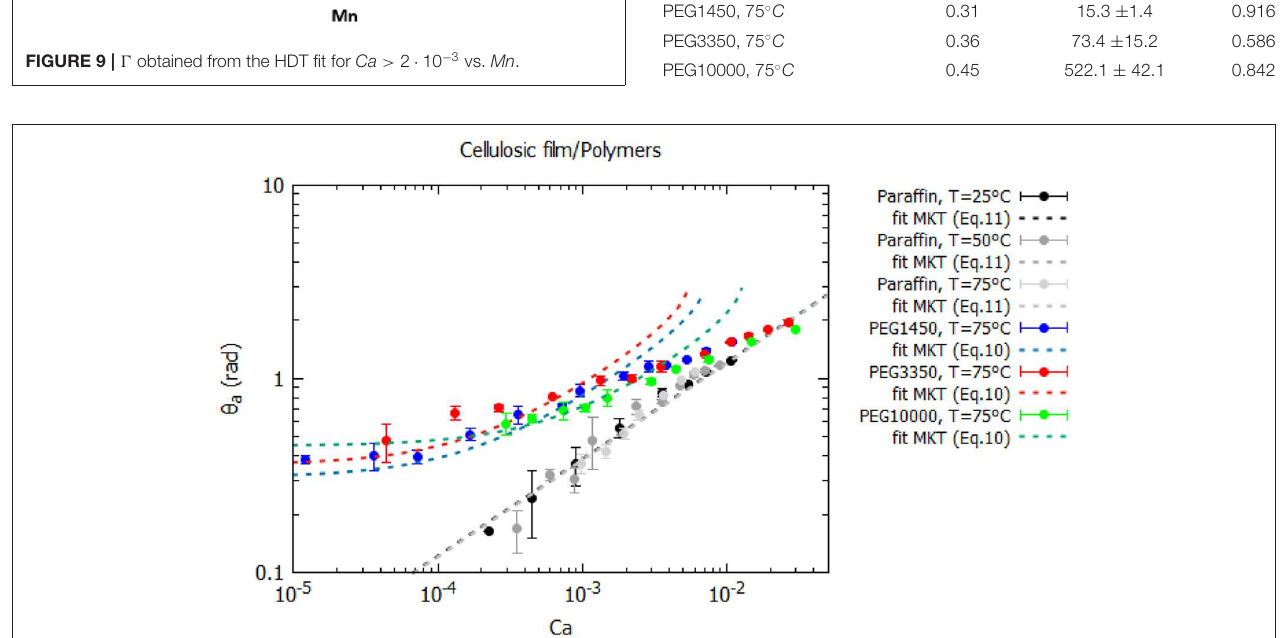
FIGURE 10 | θ a as a function of Ca for polymers at different temperatures on cellulosic films and prediction of MKT.